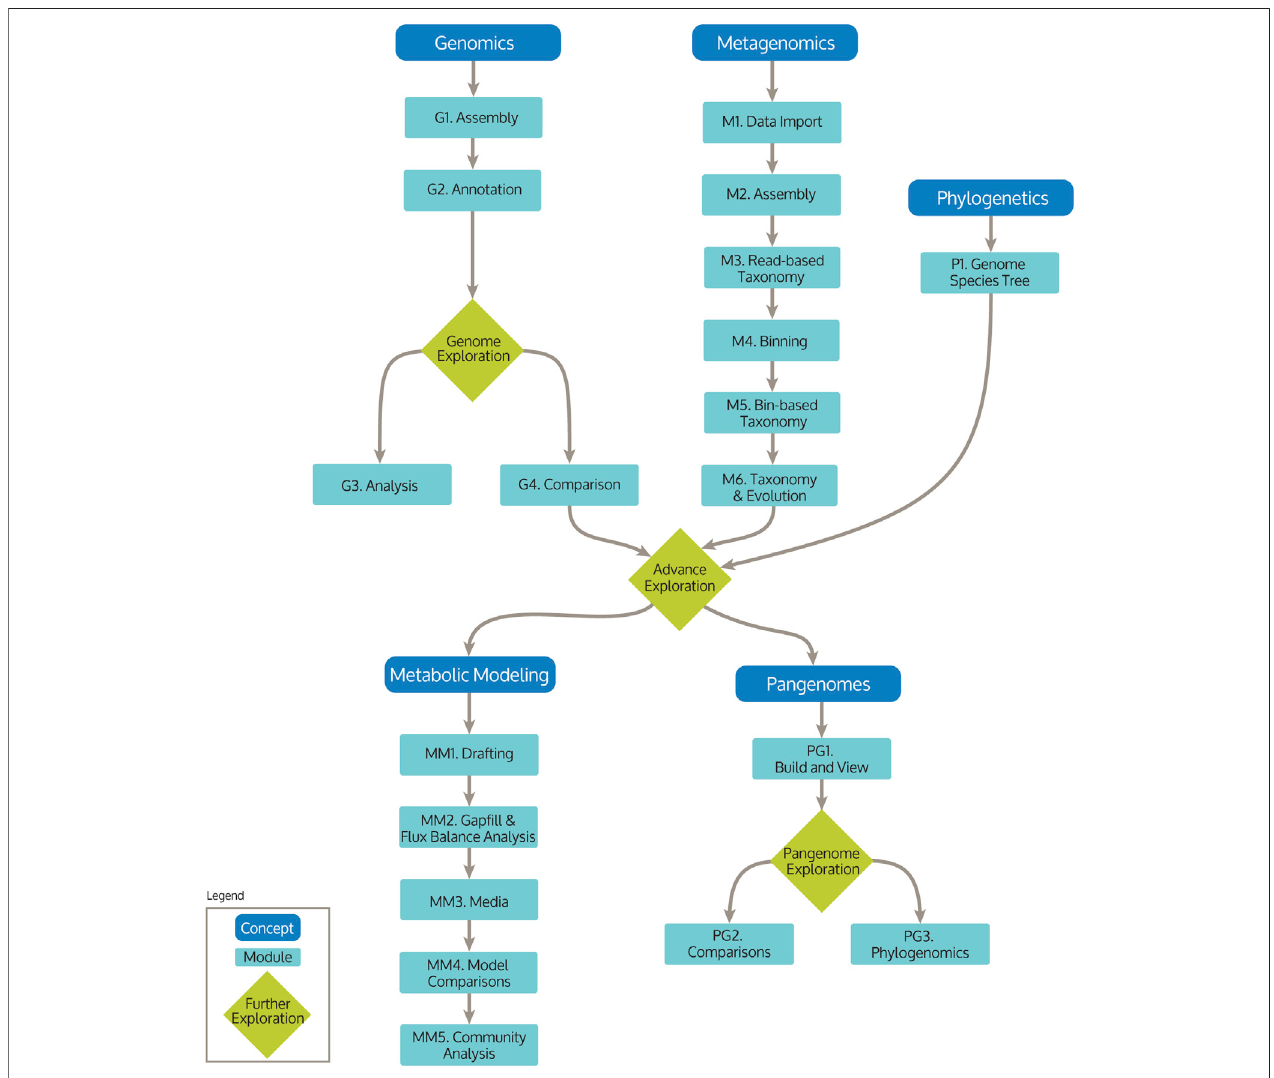
FIGURE1| KBaseEducatorsConceptWork fl owsandtheirmodules,includingGenomics,Metagenomics,Phylogenetics,Pangenomes,andMetabolicModeling.